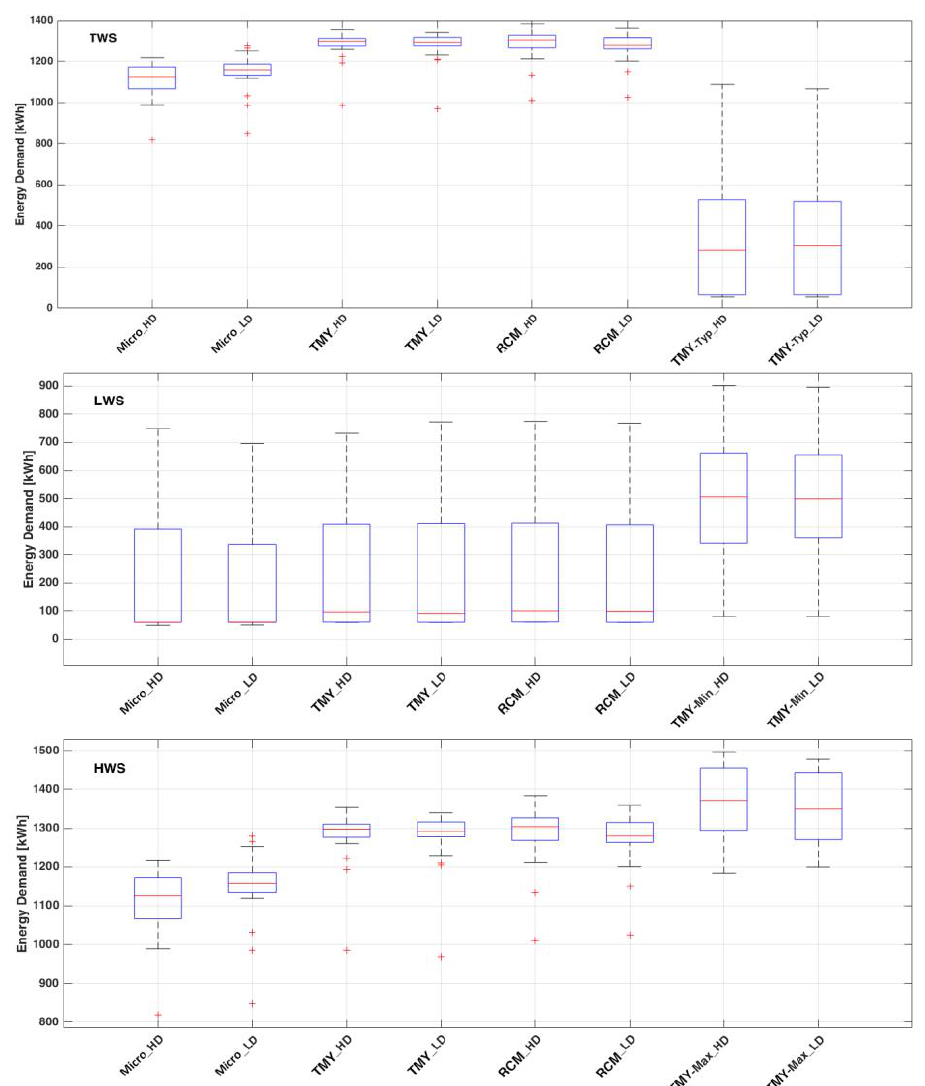
Figure 9. Boxplot of total energy demand (cooling and heating) of the central building in LD and HD HD areas adopting fifteen weather datasets. TWS: 19 February; LWS: 4 October, HWS: 15 January; areas adopting fifteen weather datasets. TWS: February 19th; LWS: October 4th, HWS: January 15th; TMY-Typ: 14 September; TMY-Min: 17 November, and TMY-Max: 13 January. HD: High density; LD: TMY-Typ: September 14th; TMY-Min: November 17th, and TMY-Max: January 13th. HD: High Low density; LD: Low density.